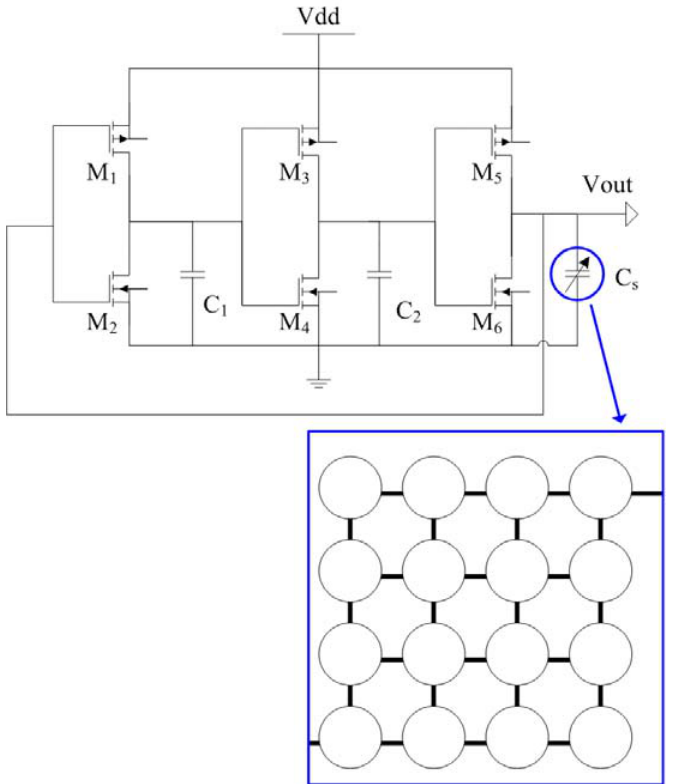
Figure 1. Schematic structure of the pressure sensor with ring